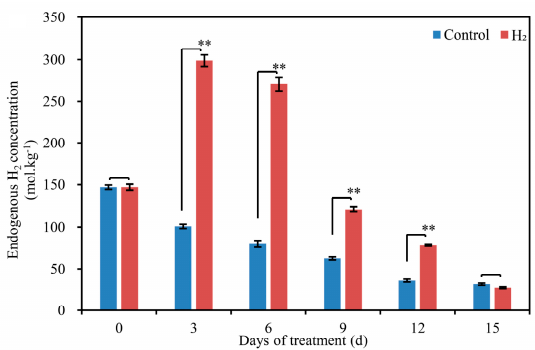
Figure 5. Changes in endogenous H 2 content in Lanzhou lily scales with or without H 2 fumigation during storage at room temperature for 15 days ( A ). The error bars indicate the means ± SE (n = 9 scales from each of three independent experiments). Values with asterisks are significantly differ- ent (* p < 0.05; ** p < 0.01) from the control treatment on the same day according to independent t- test. d: days.